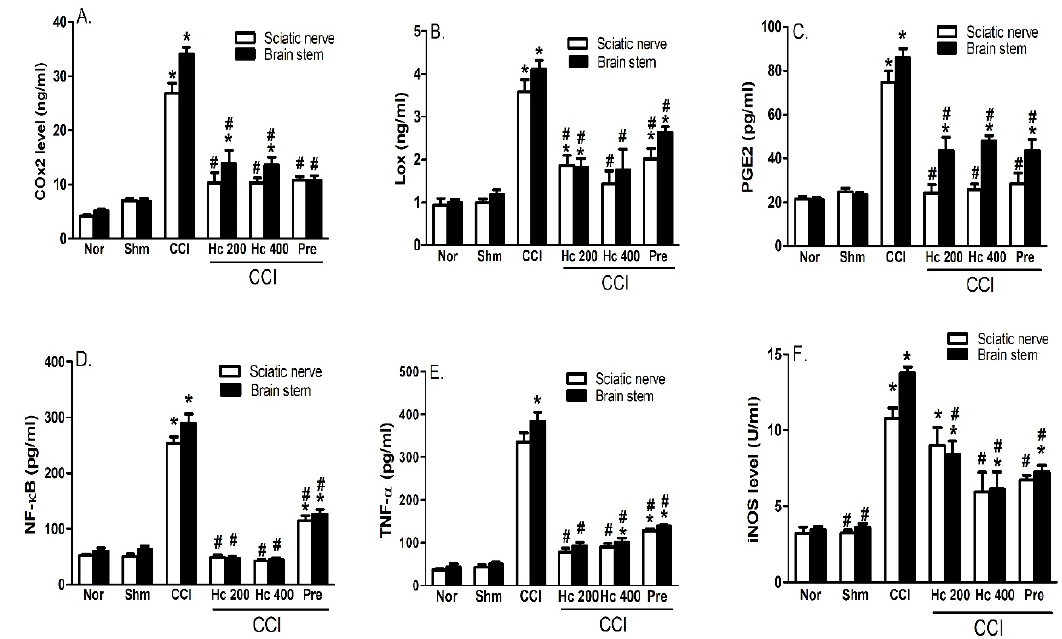
Figure 9. Effect of H. campechianum flower extract (p.o., 200 and 400 mg/kg) on CCI-induced increase Figure 9. E ff ect of H. campechianum flower extract (p.o., 200 and 400 mg / kg) on CCI-induced increase in COX2 ( A ), LOX ( B ), PGE2 ( C ), NF- κ B ( D ), TNF- α ( E ) and iNOS ( F ) levels in the brain stems and sciatic nerves of CCI rats. Values are given as mean ± S.E.M., n = 5 rats / group. * p < 0.05,